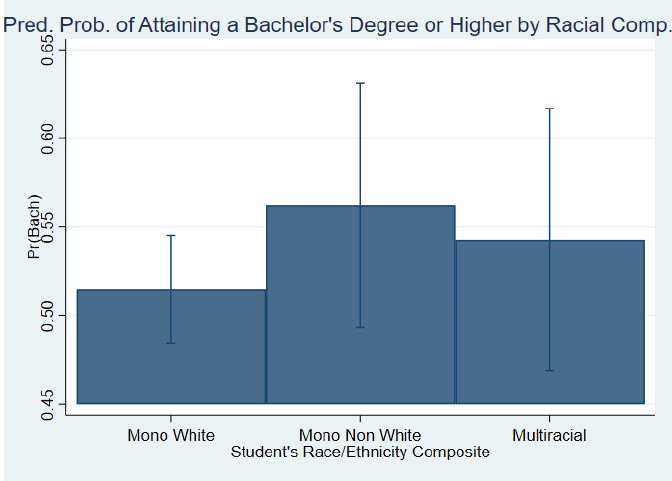
Figure 9. Pred. Prob. of BA Degree Attainment by Racial Comp. using Add Health Data.